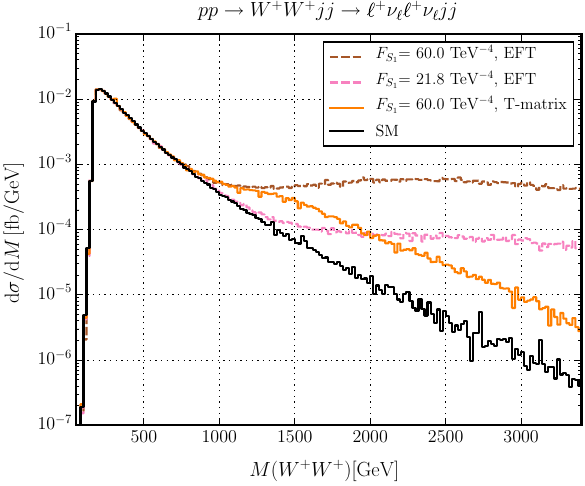
/(cid:2) 4 anomalous 1